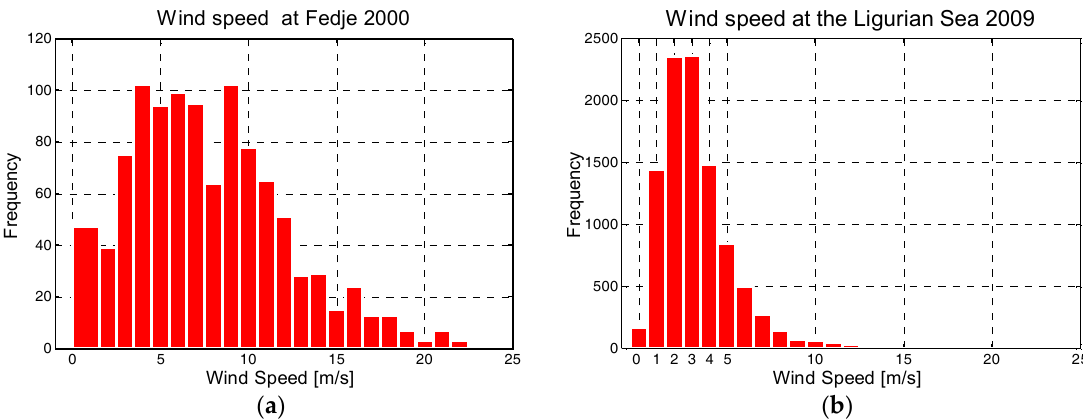
Figure 7. Statistics of wind speed measurements by the anemometer: ( a ) Norway experiment; ( b )